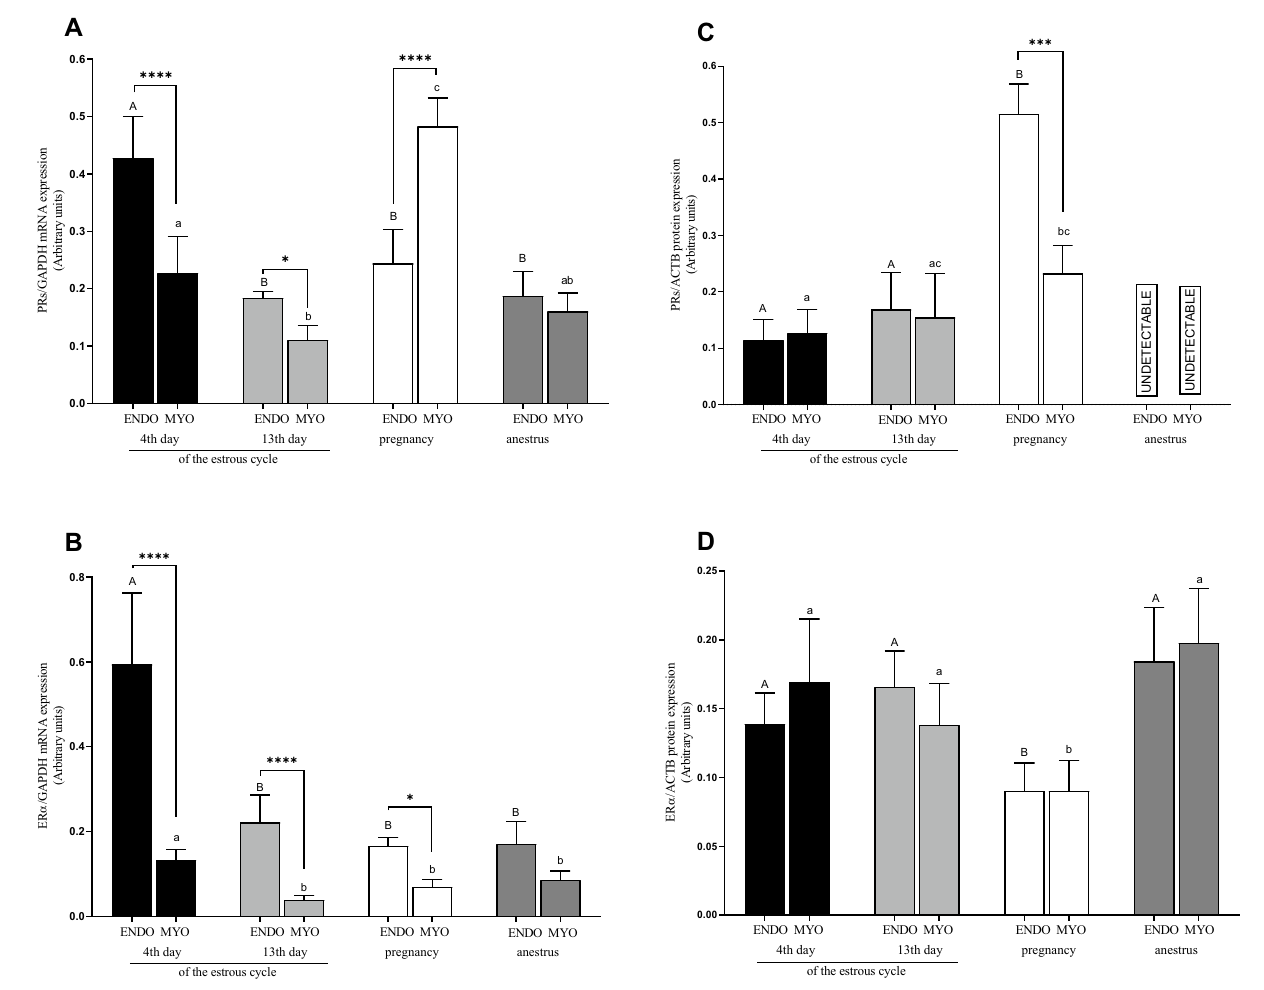
Figure 2. mRNA and protein expression of PRs ( A , C ) and ERα ( B , D ) in uterine tissues (endometrium and myometrium) on 4th and 13th day of estrous cycle, in pregnancy and anestrus phase. Data were normalized against β-actin (ACTB) for proteins expression and against GAPDH for mRNA expression. Each bar represents one experimental group with SEM. Statistical differences were analyzed by two-way analysis of variance (ANOVA) followed by the Bonferroni post hoc test using GraphPad PRISM (Version 8.3.0). The lowest statistical significance was P < 0.05. Asterisks indicate statistical differences between endometrium and myometrium (* P < 0.1; *** P < 0.001; **** P < 0.0001). Different letters indicate statistical differences ( P < 0.05) between the experimental groups throughout endometrium (A, B) and myometrium (a–c)